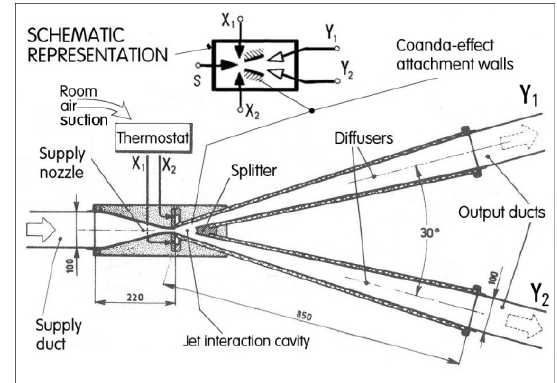
Fig. 7 Bistable diverter valve based on the jet deflection and Coanda-effect attachment. This test model was used in terminal unit off 100 mm wide rectangular model ducts. The area contraction in the supply nozzle together with the pressure rise in the long diffusers creates in the control pipes X 1 and X 2 a sub-atmospheric pressure, which is used to suck into the valve the room air passing en route through the thermostat.